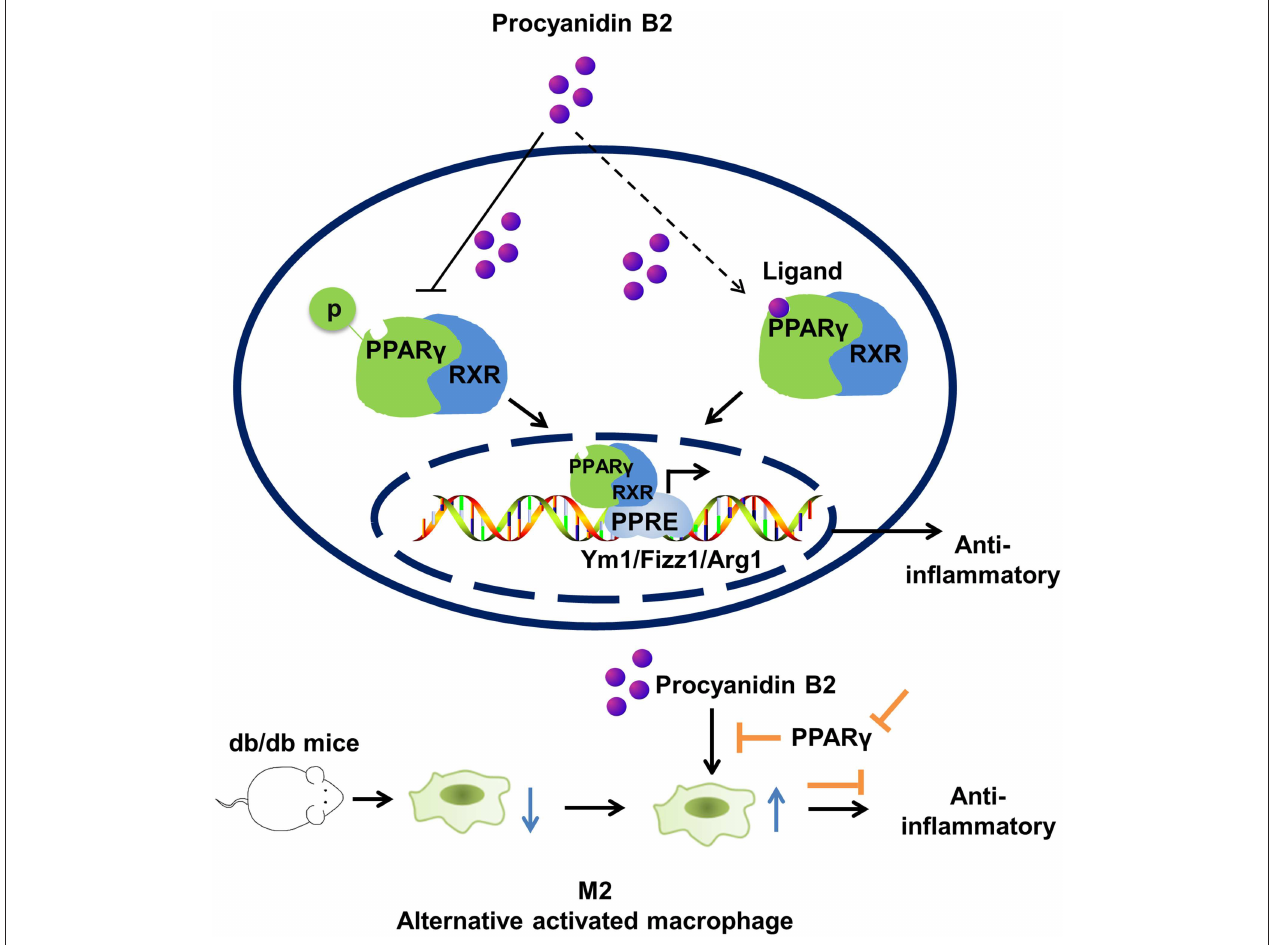
FIGURE 7 | Effect of PCB2 on macrophage polarization. PCB2 enhanced the expressions of M2 markers (Arg1, Ym1, and Fizz1) and activated PPAR γ activity in macrophages. Compared with db/m + control mice, macrophages isolated from db/db diabetic mice showed an impaired M2 phenotype. PCB2 effectively restored the M2 polarization in a PPAR γ -dependent